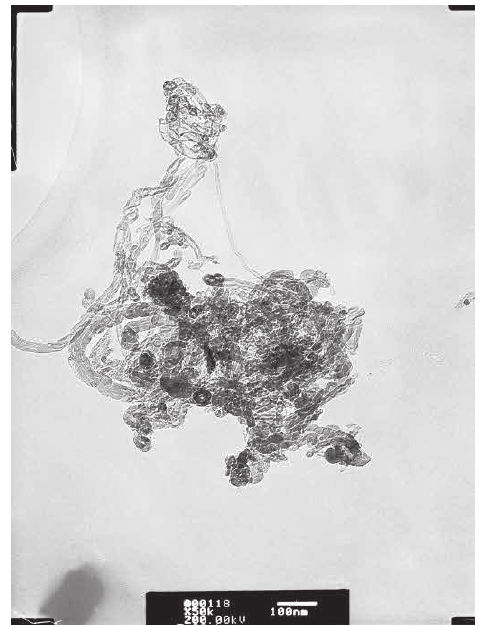
Figure 7. TEM image of sol-gel prepared TiO